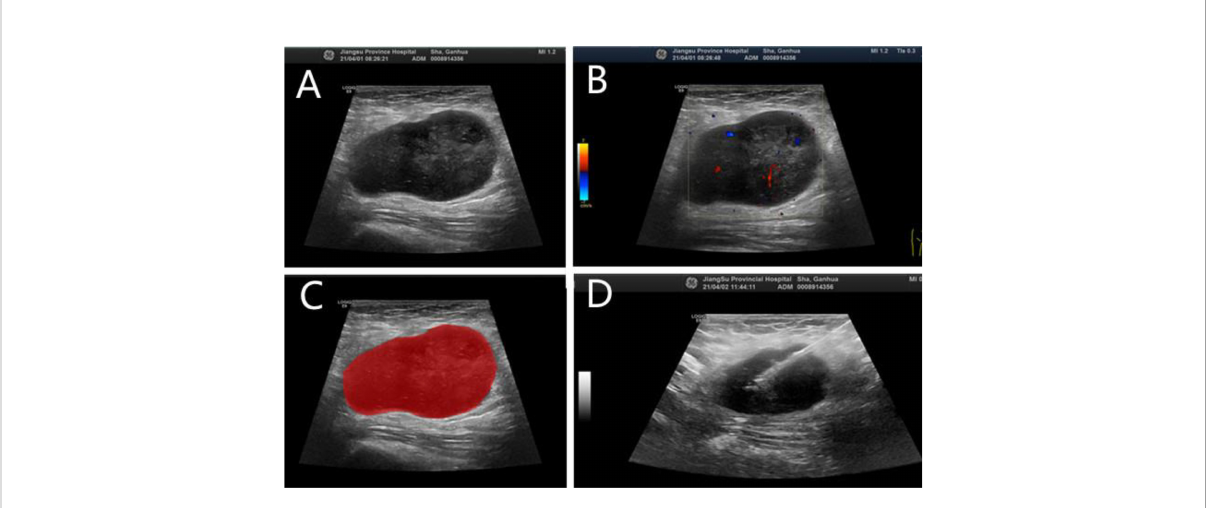
FIGURE 2 N-DLBCL in a 58-year-old man. (A) Gray-scale ultrasonic image. (B ) CDFI image. (C) Radiomic ROI segmentation segmentation of the mass. (D) Ultrasound-guided core needle